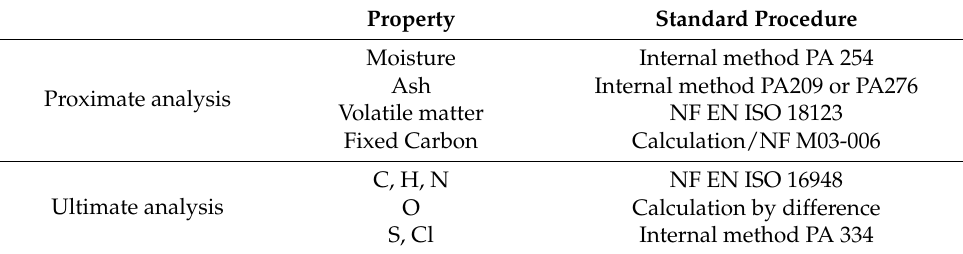
Table 2. Proximate and ultimate analyses